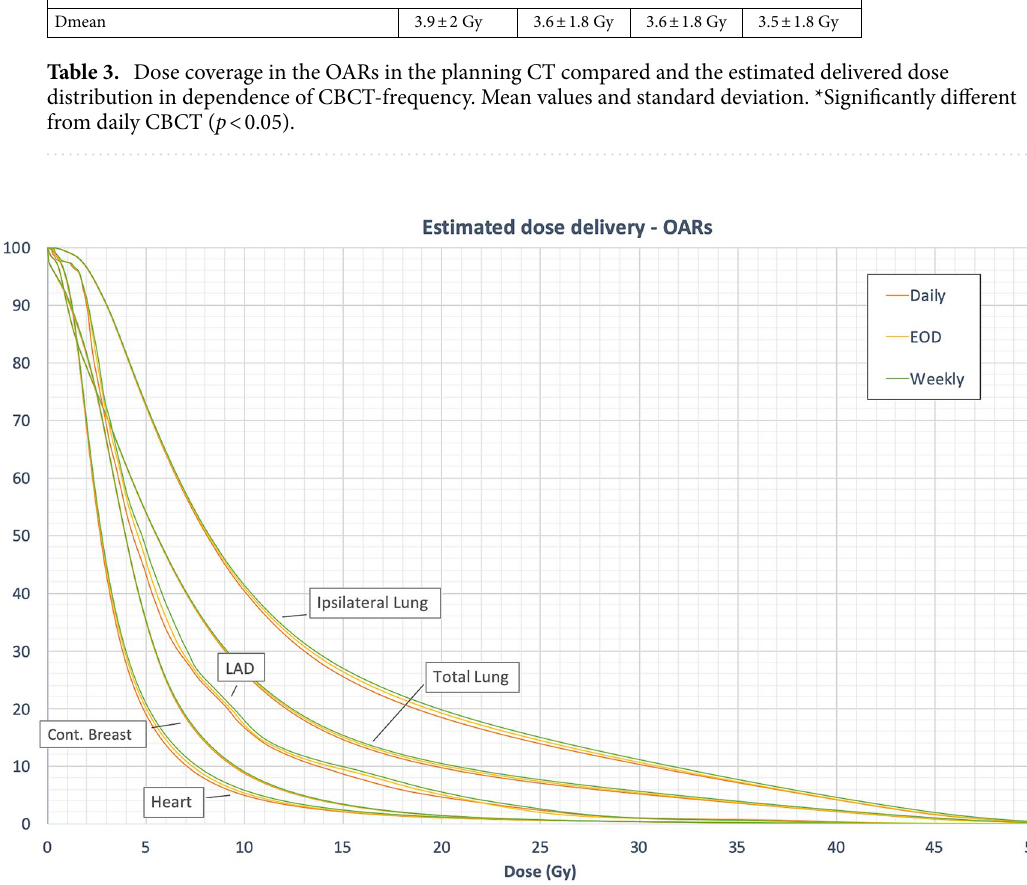
Figure 4. Dose volume histograms delineating the estimated delivered dose in the OARs. Mean values of 45 patients with a prescribed to the Breast-PTV of 50.4 Gy and 58.8 Gy or 63 Gy, respectively, to the